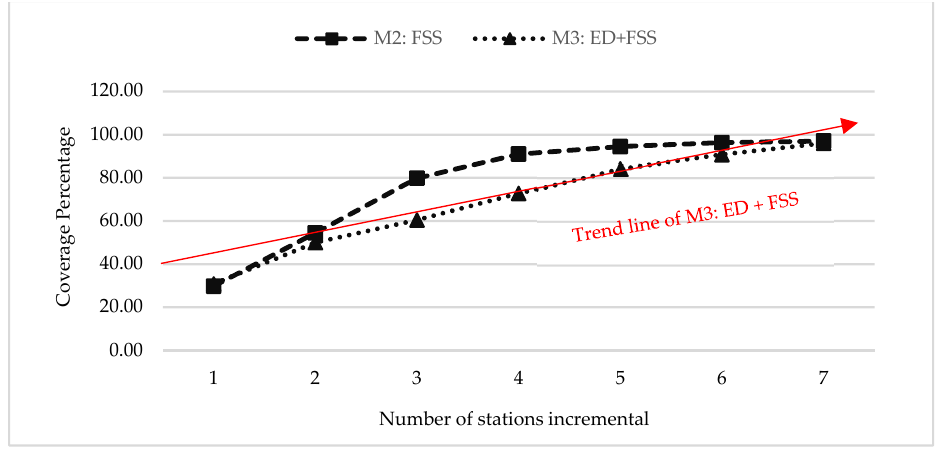
Figure 7. Plot of historical coverage percentage versus number of stations in Sejong.